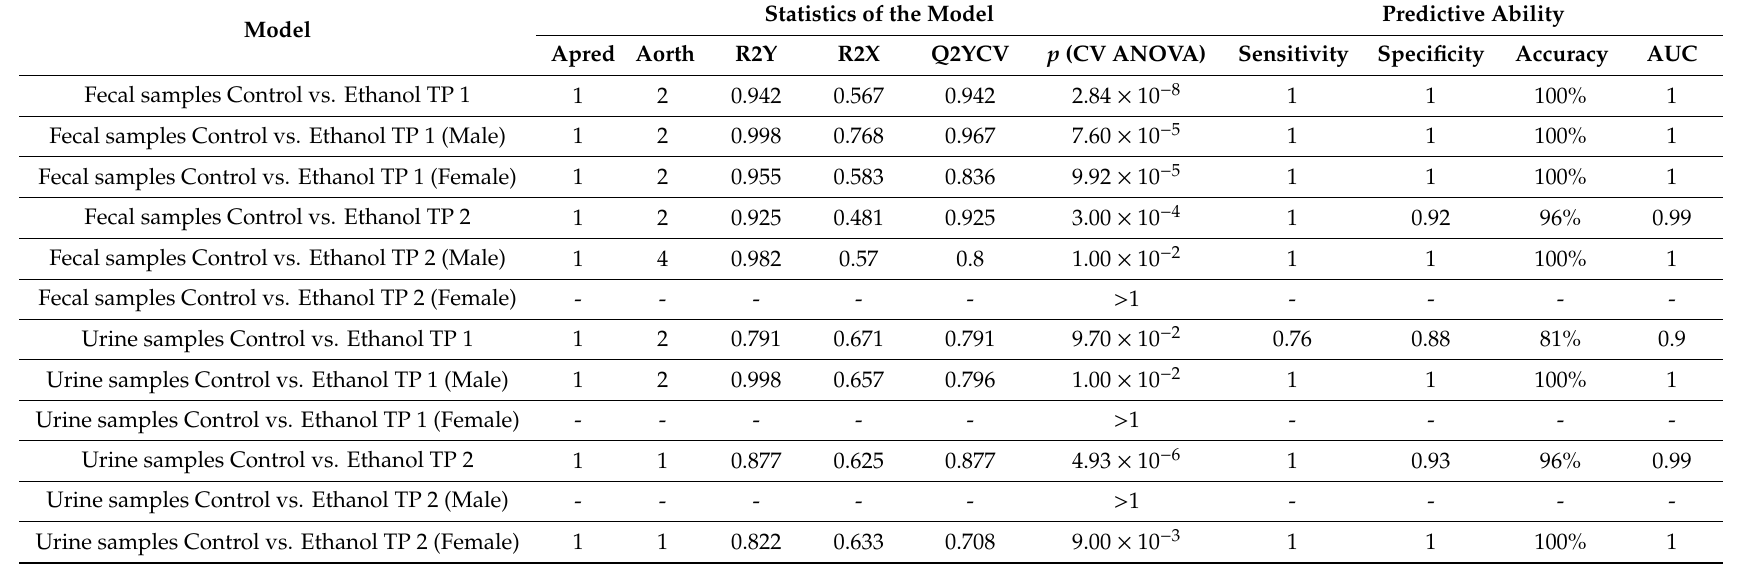
Table 1. Data statistics from all constructed OPLS DA